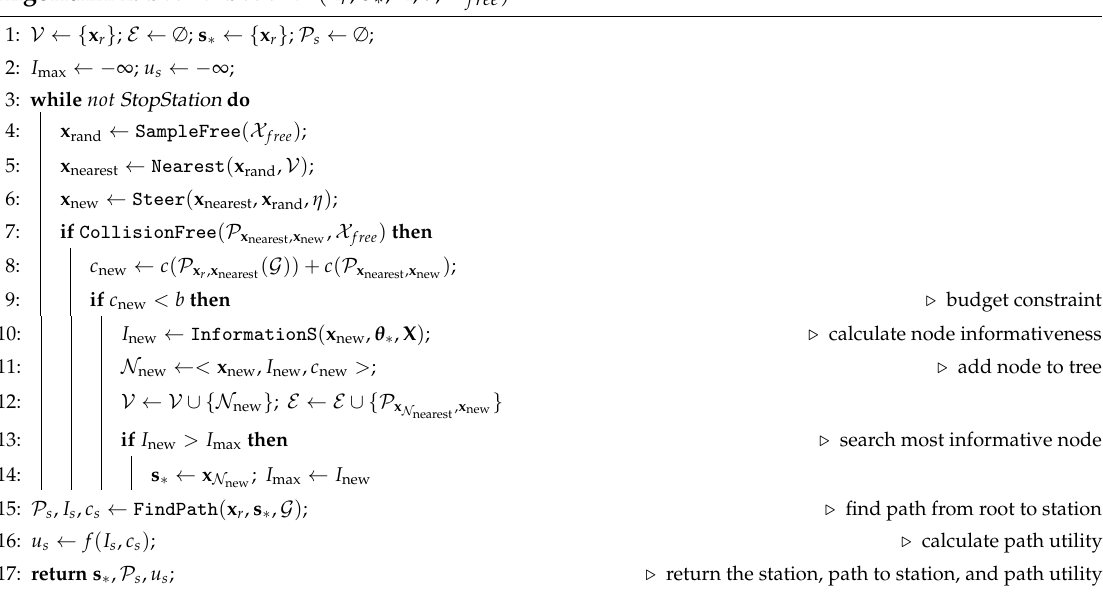
Algorithm 2. SearchStation ( x r , θ